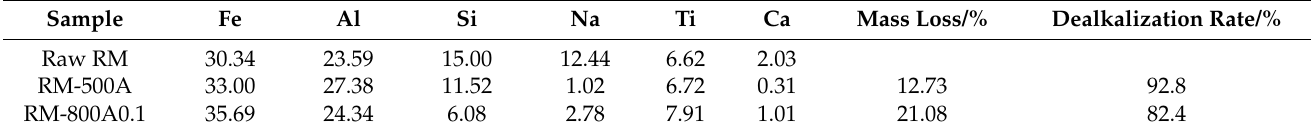
Figure 9. The Na content, mass loss, and dealkalization rate of three samples. The schematic diagram of the diluted acid leaching strategy is shown in Figure 10.